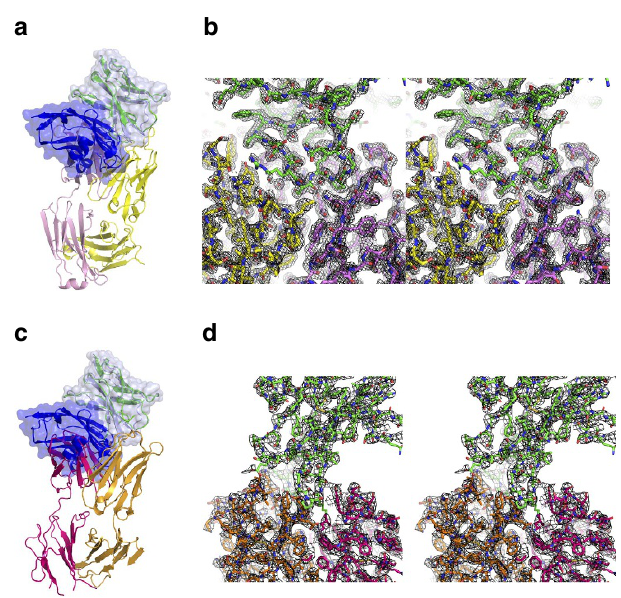
Figure 1 | Crystal structures of PD-1 in complex with anti-PD-1 drugs. ( a ) Ribbon representation of the complex structure of PD-1/pembrolizumab Fab fragment. The heavy and light chains of pembrolizumab are coloured pink and yellow, respectively. PD-1 in the complex is coloured green. ( b ) Stereoview of the 2fo-fc composite omit map (1.2 s contour level) at the interface between PD-1 (green) and pembrolizumab (heavy chain: pink, light chain: yellow) calculate at 2.0Å resolution. ( c ) Ribbon representation of the complex structure of PD-1/nivolumab Fab fragment. The heavy and light chains of nivolumab are coloured orange and purple, respectively. PD-1 in the complex is coloured green. ( d ) Stereoview of the 2fo-fc composite omit map (1.2 s contour level) at the interface between PD-1 (green) and nivolumab (heavy chain: orange, light chain: purple) calculated at 3.3Å resolution. In a and c, the PD-1/PD-L1 complex (PDB code 4zqk) was superimposed onto the PD-1 molecule in the PD-1/anti-PD-1 complexes with mixed ribbon/surface representation. PD-1 and PD-L1 in the PD-1/PD- L1 complex are coloured pale blue and blue,